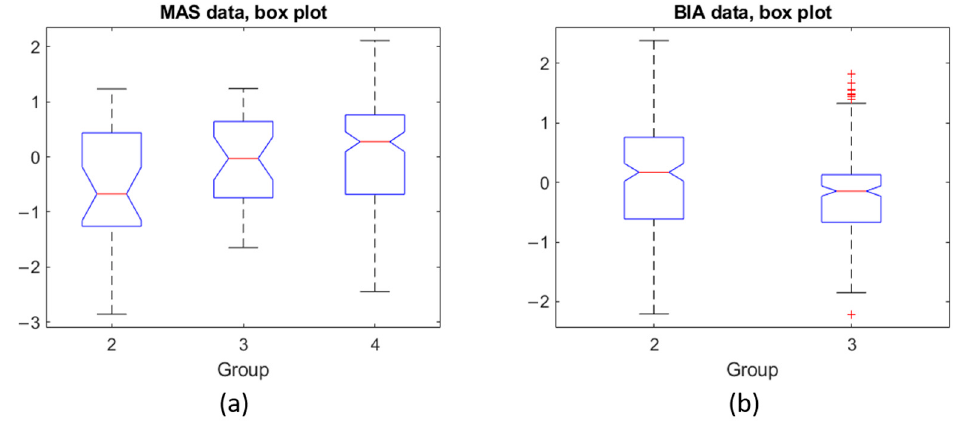
Figure 14. ( a ) Box plot for each group of the MAS data, ( b ) Box plot for the two groups of BIA data.